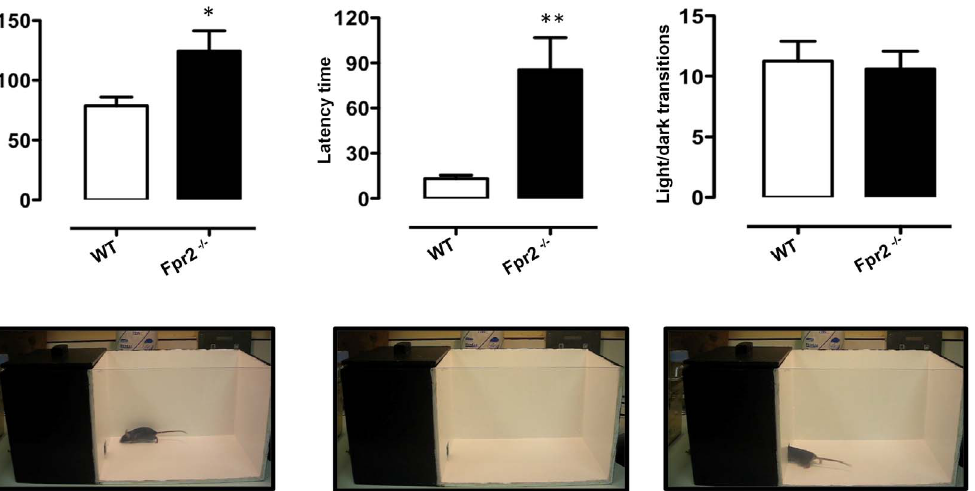
Fig. 3. Reduced anxiety-like behaviour of Fpr2/3 -/- mice in the light and dark box test. The bar graphs and images show the total time (seconds) spent in the lit area, latency (seconds) to first cross to the dark chamber and total number of transition during a 5-minute trial. Values are expressed as median ¡ S.E.M. and representative of four different experiments involving 6–9 mice per group. * P , 0.05 and ** P , 0.05 indicate significant values compared with wild-type (WT) control mice (Mann–Whitney U -test).